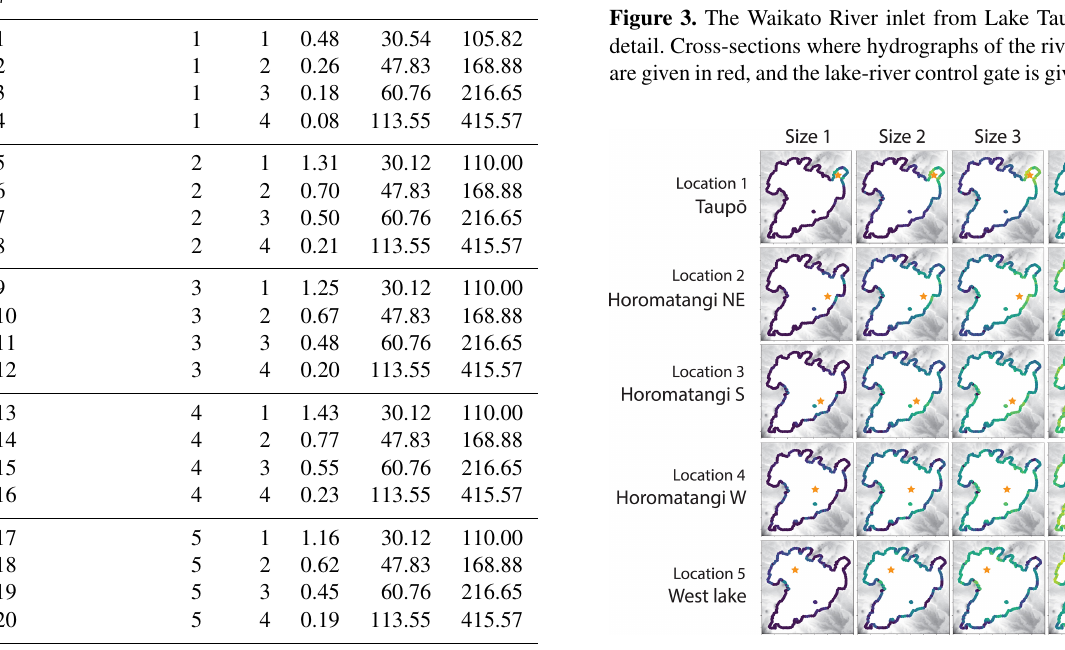
Figure 4. Scenario matrix illustrating maximum wave amplitudes reached across the lake foreshore, where sizes are detailed in Table 1 and locations in Table